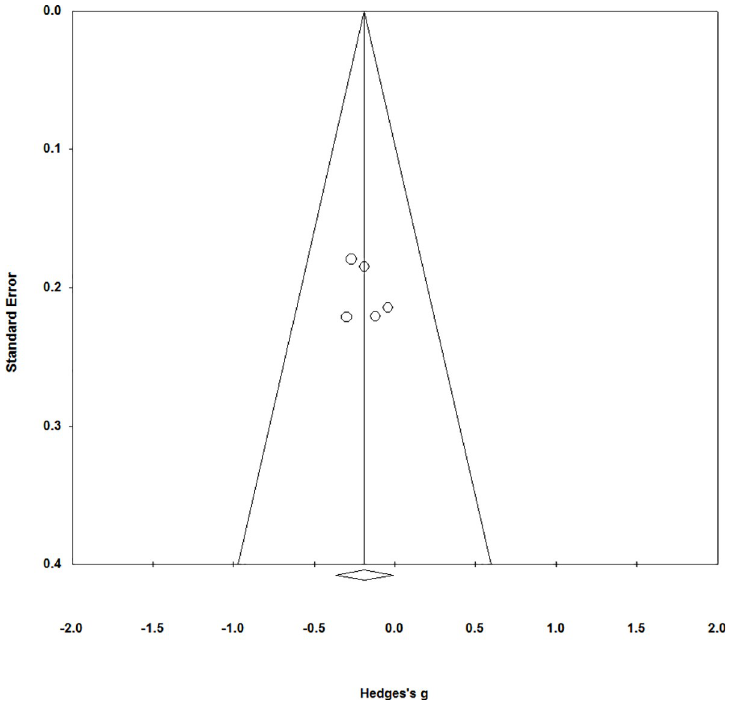
Fig 3. Funnel plot for the meta-analysis of brief interventions vs. assessment only control